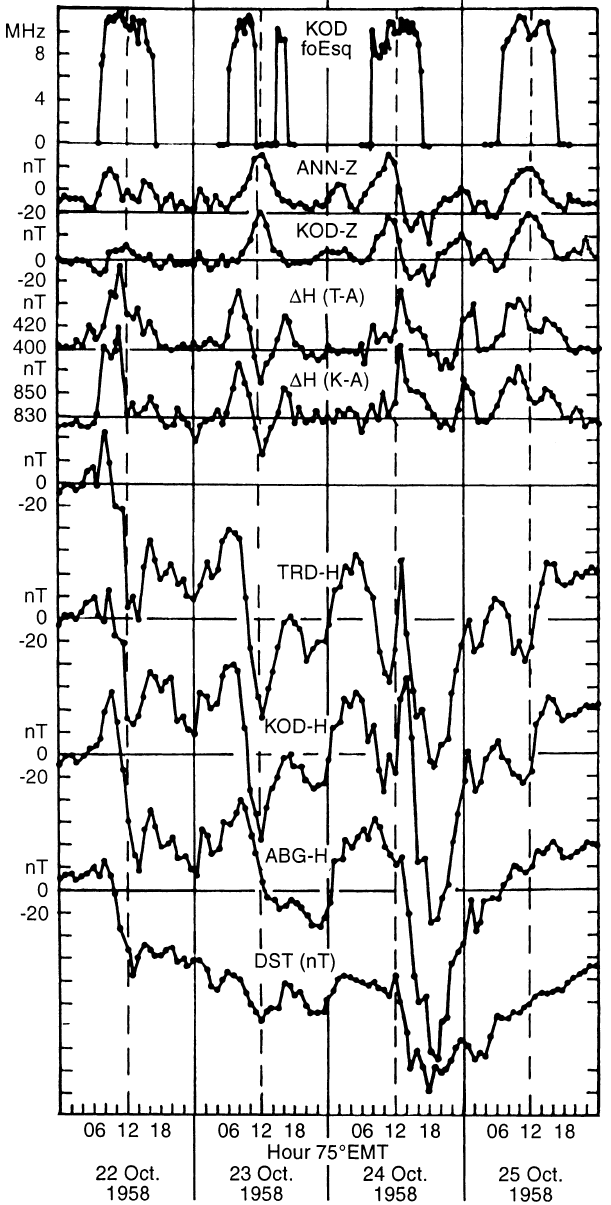
Fig. 5. The storm time variations of Dst index, H fields at ABG, KOD, TRD, (cid:68) H (K-A), (cid:68) H (T-A), KOD Z , ANN Z and f o Esq at Kodaikanal during the sudden commencement storm starting at 75 (cid:14) h EMT on 1 December 1960